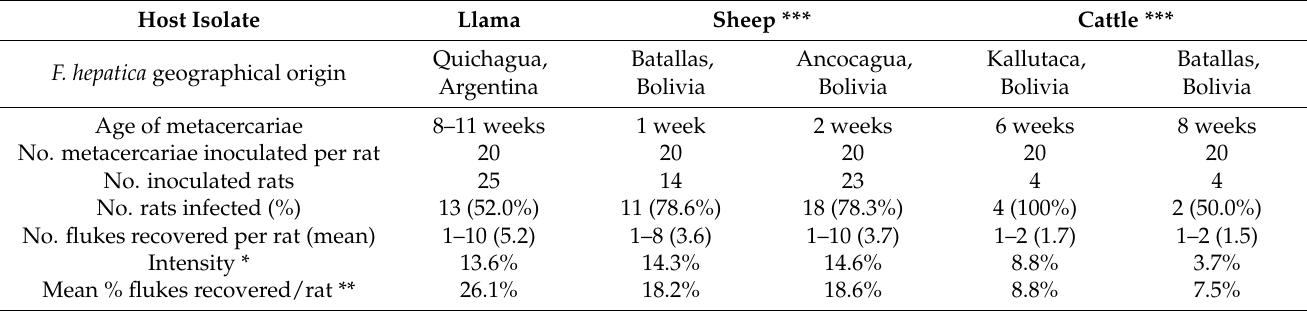
Table 2. Experimental infections of Wistar rats with experimentally obtained metacercariae from the llama isolate from Quichagua, Argentina, and comparison with sheep and cattle isolates from the Northern Bolivian Altiplano human hyperendemic area. Llama Sheep *** Cattle